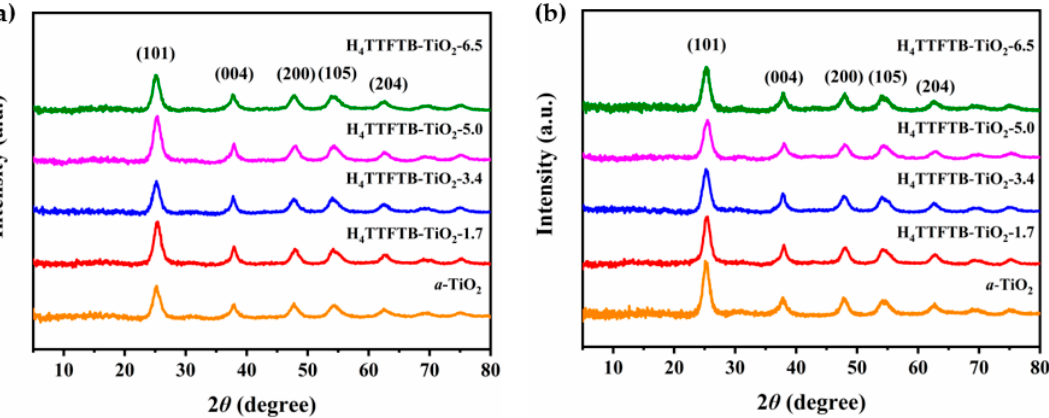
Figure 1. XRD of H 4 TTFTB-TiO 2 with different H 4 TTFTB amounts were listed above without ( a ) and with ( b ) 250 °C calcination.